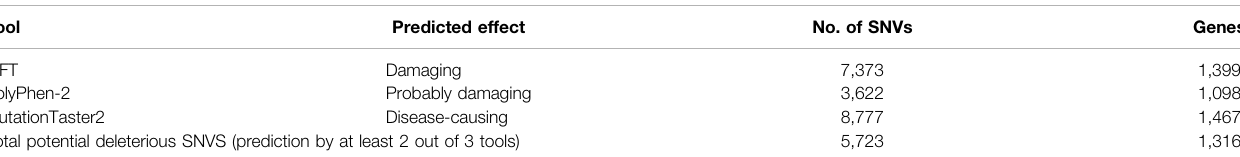
TABLE 2 | Summary of functional effect prediction of nonsynonymous variants.